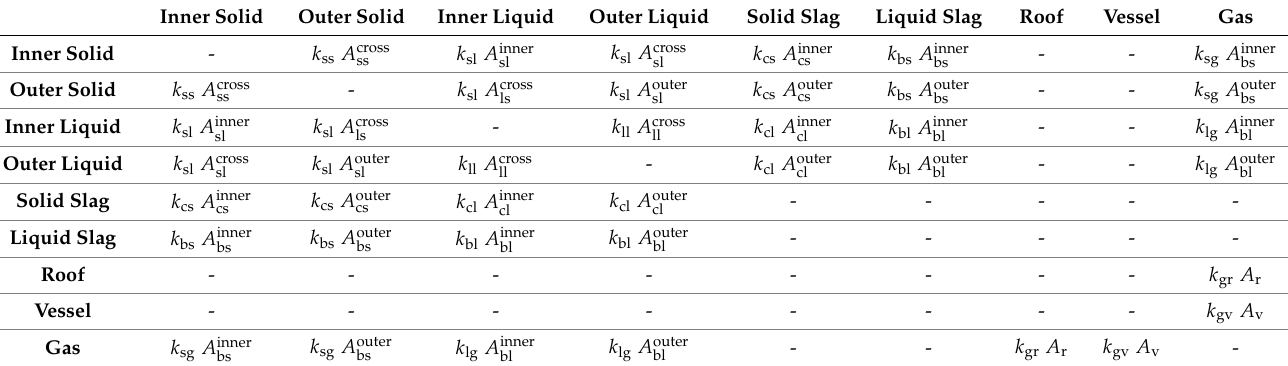
Table 2. Prefactors for linear heat transfer between different masses in the furnace. The subscript letters (s, l, c, b, r, v, g) refer to (solid steel, liquid steel, solid slag, liquid slag, roof, vessel, gas), respectively. An empty table entry indicates that linear heat transfer between the two masses is omitted from the